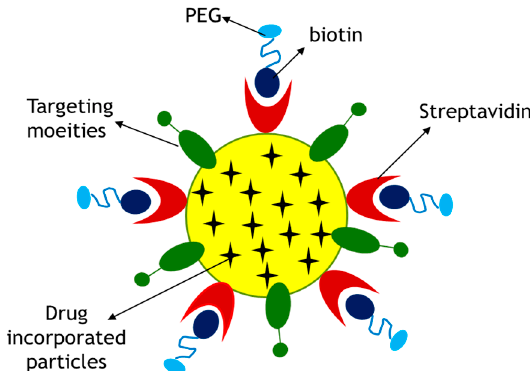
Figure 12. Proposed surface modification model for a drug-loaded CA particle. Surface modification involves PEGylation and attachment of a targeting moiety to drug–apatite complexes. Streptavidin was used as a linker between drug–apatite particles and biotin–PEG, since biotin has specific affinity towards straptavidin. A cell-targeting moiety, such as fibronectin, is attached to the particles via ionic interactions.